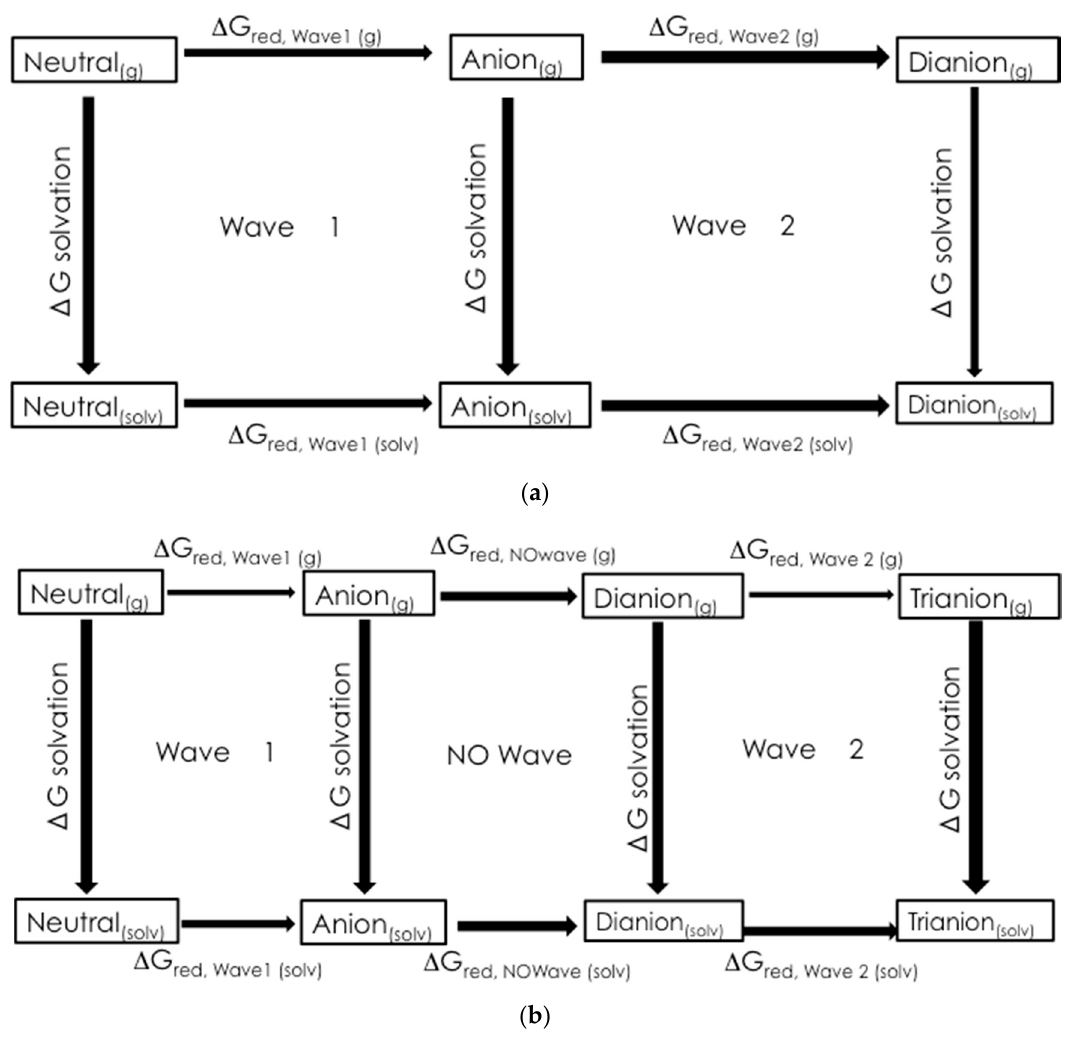
Figure 9. The thermodynamic cycles used to calculate Δ G red : ( a ) wave 1 (1st N -oxide reduction) and wave 2 (2nd N -oxide reduction) for 1a – 1d and ( b ) wave 1 (1st N -oxide reduction), NO wave (nitro group reduction) and wave 2 (2nd N -oxide reduction) for 1e .